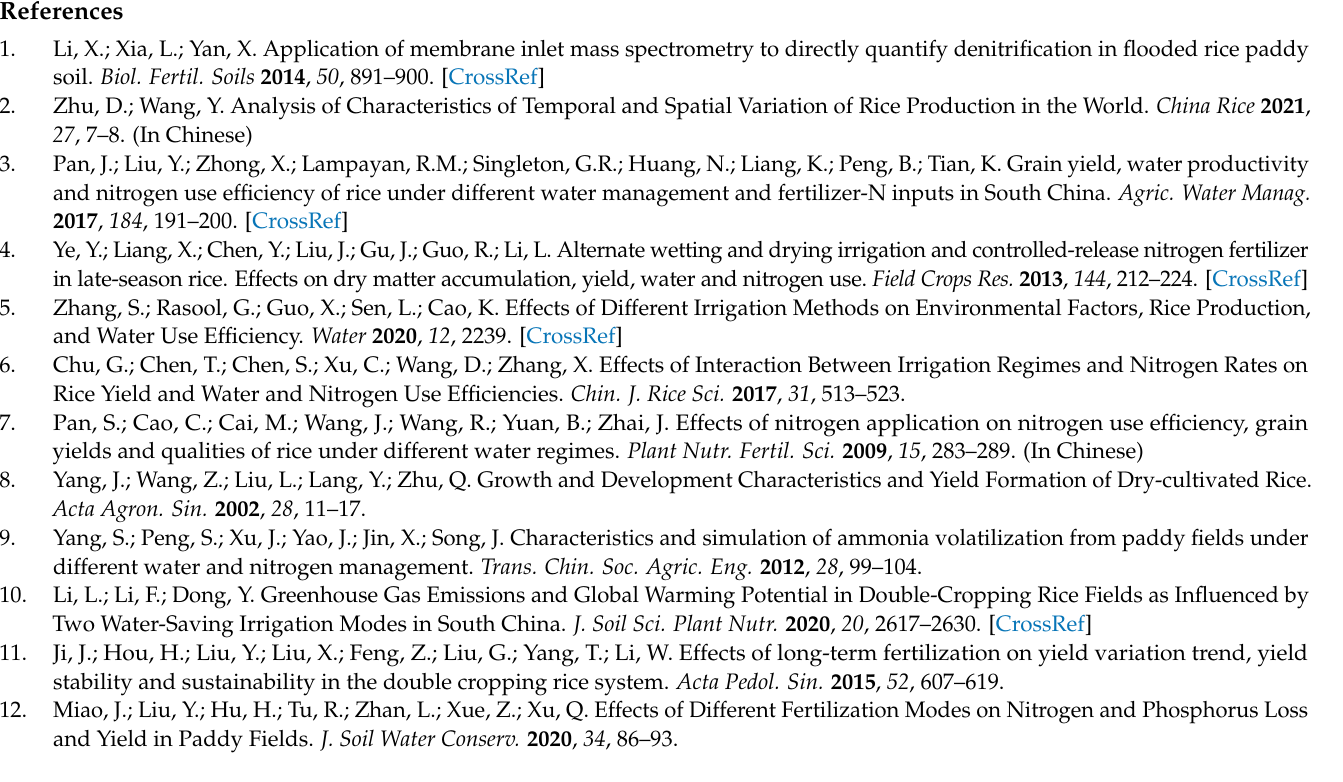
Table S11:The effect of nitrogen application on nitrogen runoff ( p = 0.52096); Table S12: The effect of water-nitrogen coupling on nitrogen runoff ( p = 0.53041); Table S13: The effect of irrigation schedules on nitrogen leaching ( p = 0.00000); Table S14: The effect of nitrogen application on nitrogen leaching ( p = 0.44466); Table S15: The effect of water-nitrogen coupling on nitrogen leaching ( p = 0.24925); Table S16:The effect of irrigation schedules on nitrogen NH 3 ( p = 0.02987); Table S17: The effect of nitrogen application on nitrogen NH 3 ( p = 0.00000); Table S18: The effect of water-nitrogen coupling on nitrogen NH 3 ( p =